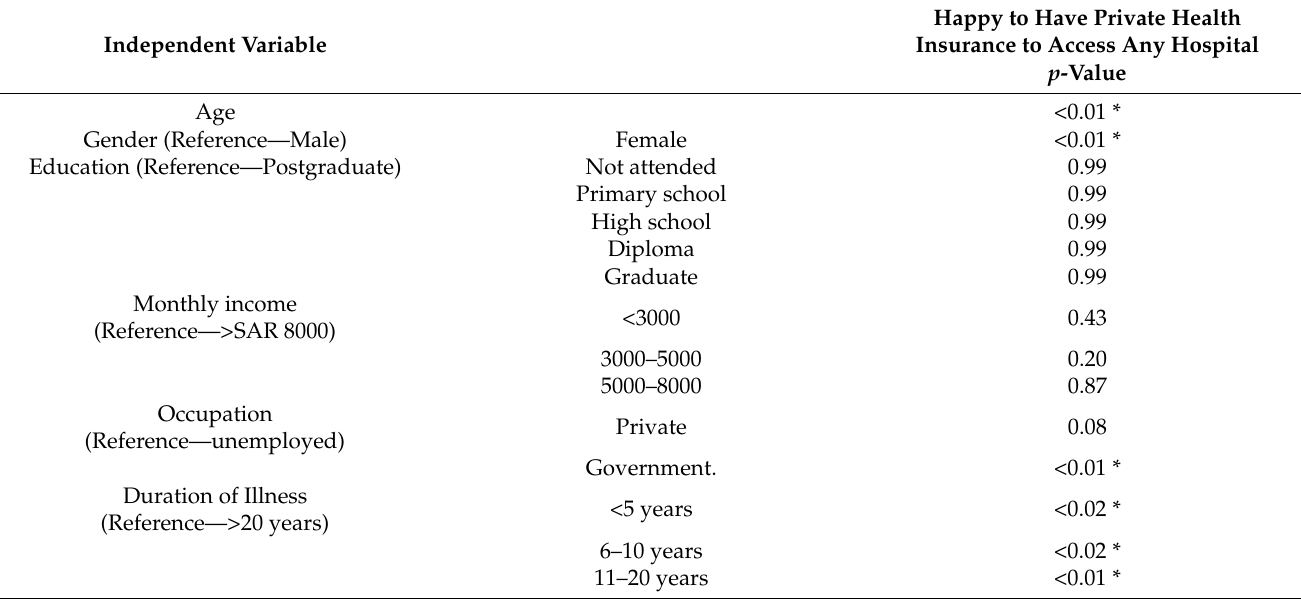
Table 2. Patients’ perception of private health insurance n =